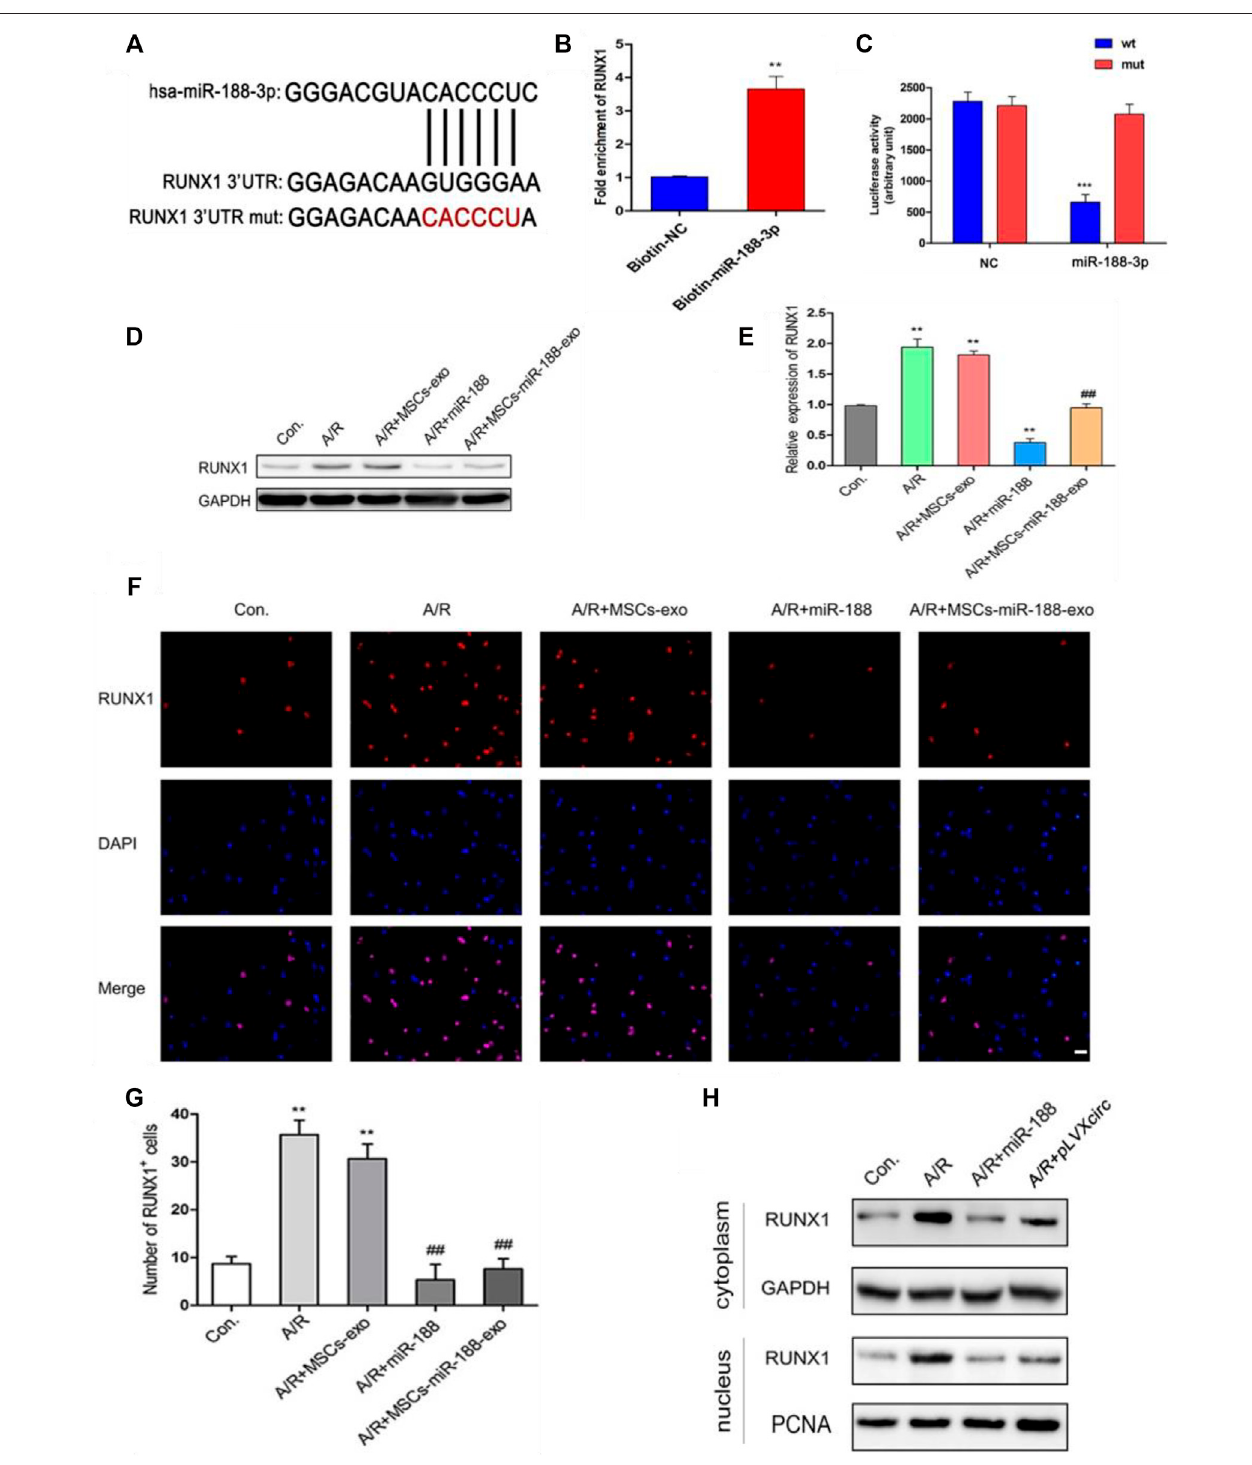
FIGURE4| miR-188-3p suppressed RUNX1 nucleartranslocation inA/R H9C2 cells. (A) The potential interaction sequence betweenmiR-188-3pand RUNX1 as identi fi ed by the target prediction program. (B) The RNA pull-down assay and (C) dual-luciferase reporter assay were used to determine the interaction of miR-188-3p withRUNX1inH9C2cells. (D,E) TheRUNX1proteinexpressionafter1 hofanoxiaand8 hreoxygenationfollowingdifferenttreatments. (F) Co-labeledRUNX1andDAPI inH9C2cellsafter1 hofanoxiaand8 hofreoxygenationfollowingdifferenttreatments.Scalebar:25 μ m. (G) ThenumberofRUNX1positivecellswasdetermined following different treatments. (H) RUNX1 protein levels in cytoplasm and nucleus following either miR-188-3p up-regulation or circRNA_0002113 down-regulation. ** p < 0.01, *** p < 0.001, compared with the control. # p < 0.05, ## p < 0.01, ### p < 0.001, compared with the A/R group.